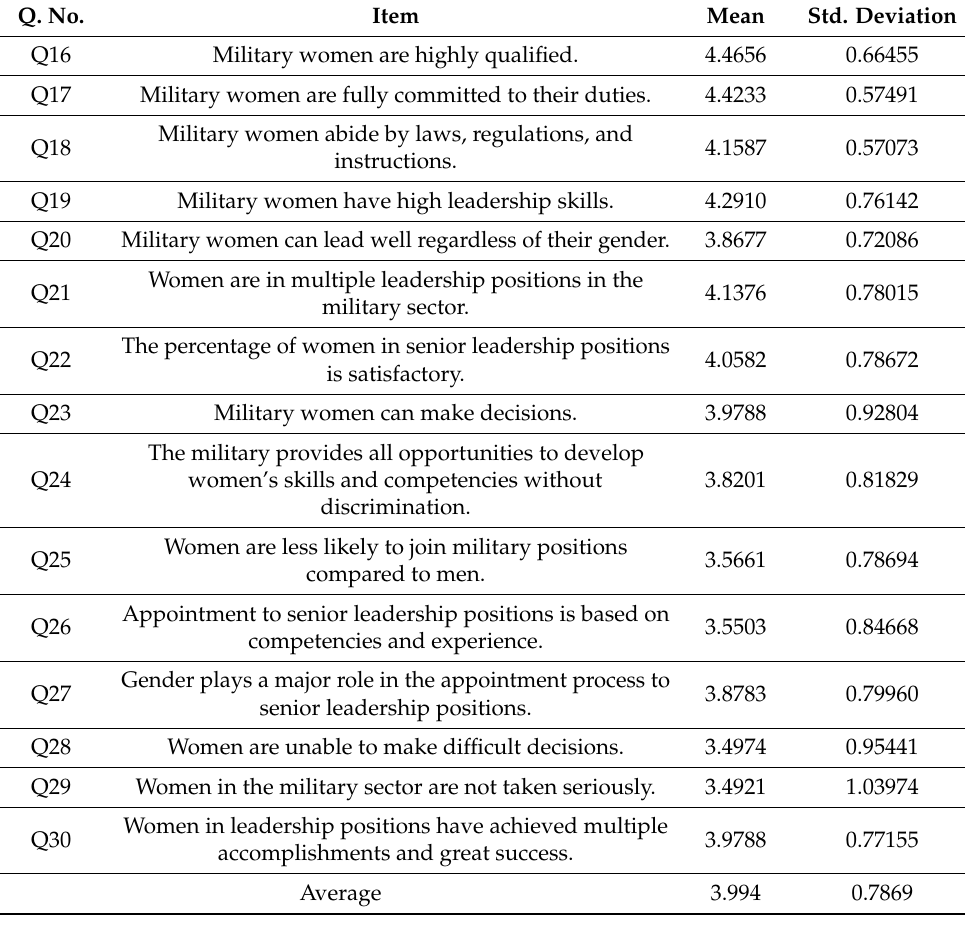
Table 2. Descriptive analysis of measurement items of leadership.